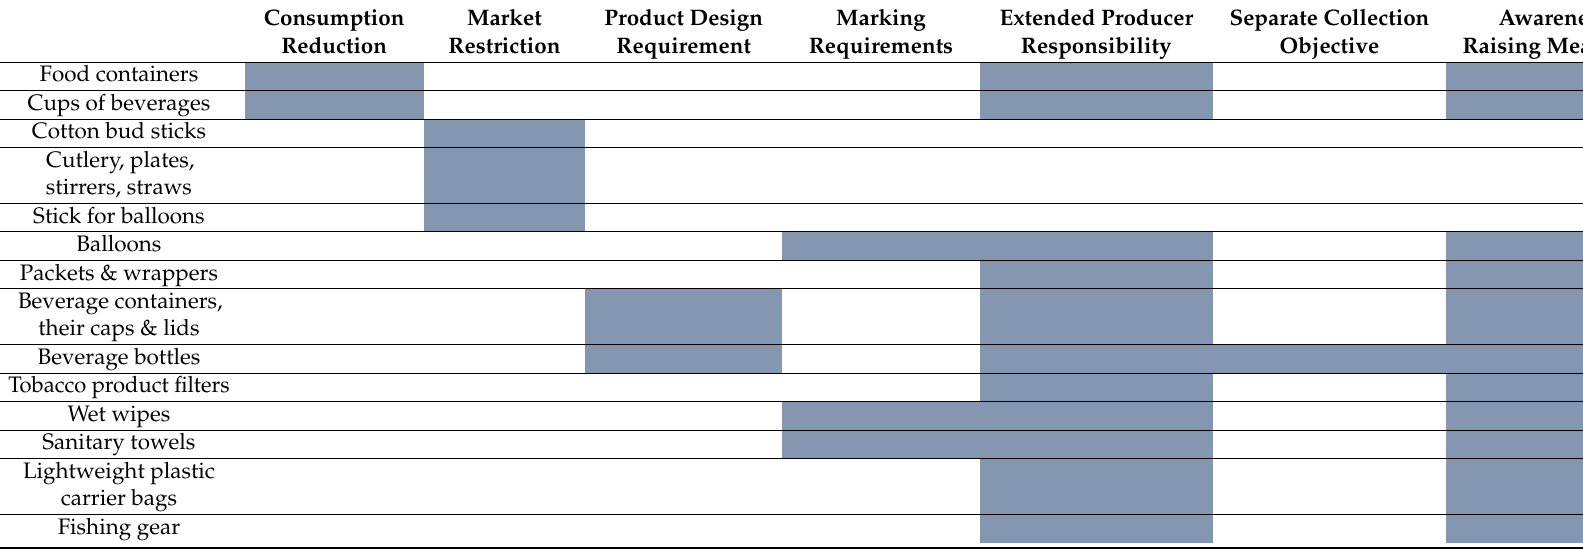
Table 1. Actions for single-use plastic items and fishing gear– Source: European Commission, Proposal Directive on the reduction of the impact of certain plastic products on the environment